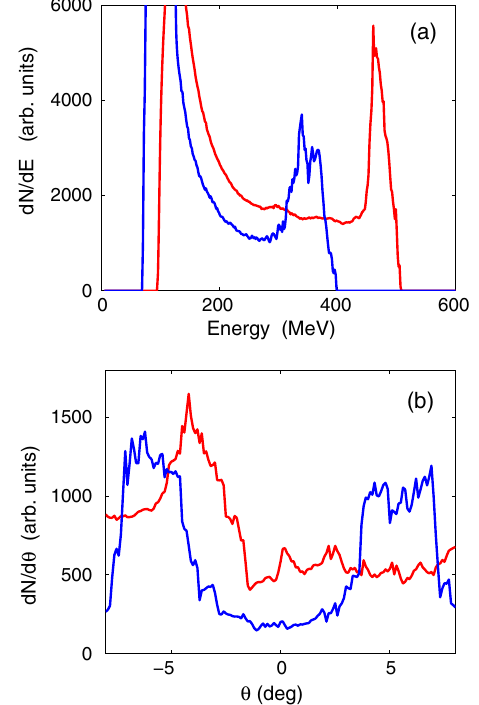
FIG. 1. (a) Energy and (b) angle spectra of the TNSA protons behind the target at t ¼ 200 T . The red and blue curves are for the cases with and without the preplasma, respectively. One can see that the preplasma leads to higher energy, narrower and single- peaked angular distribution, as well as more monoenergetic protons. The laser axis is at θ ¼ 0